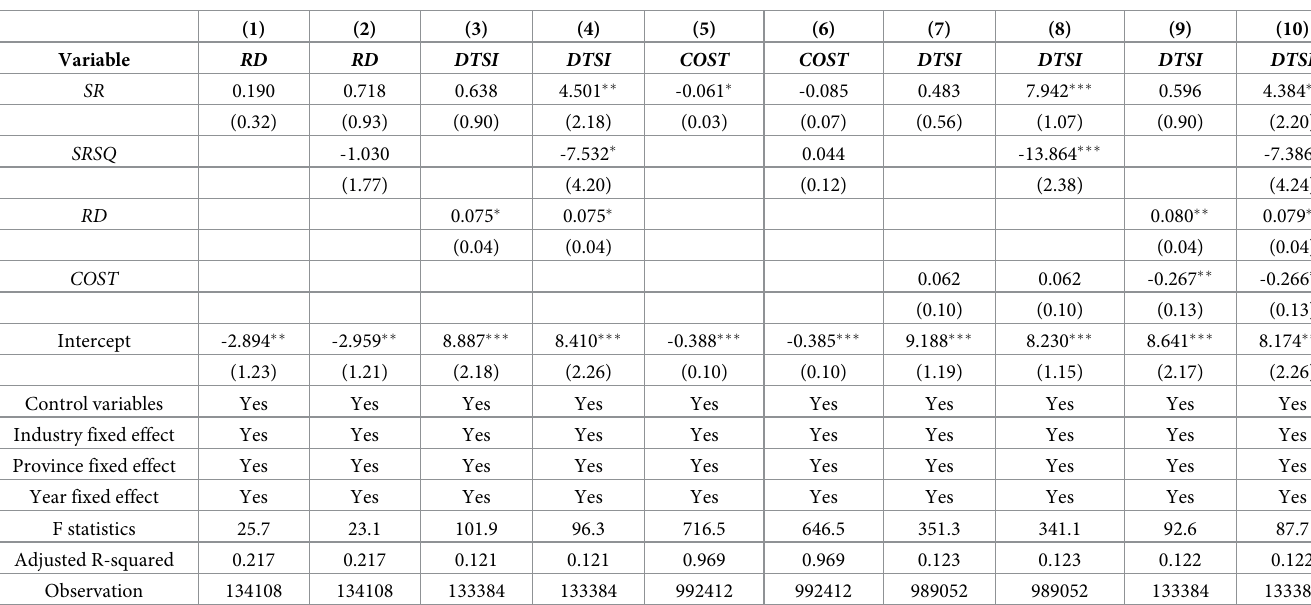
in columns (4) and column (8) with the mediation variables of enterprise R&D innovation and production cost, the estimation coefficient of manufacturing servitization is significantly lower than that of the benchmark model, both in value and significance. The above results fully show that R&D innovation and production cost are two possible mediation channels for manufacturing servitization to affect export technological sophistication. In column (9), the two mediation variables are added to the regression equation to estimate. It is found that the estimation coefficient of manufacturing servitization is still positive, but compared with the result of benchmark regression, its estimated coefficient is smaller and has not passed the sig- nificance test of 10%. However, the estimated coefficients of R&D innovation and production cost of mediation variables are consistent with the corresponding results of column (4) and